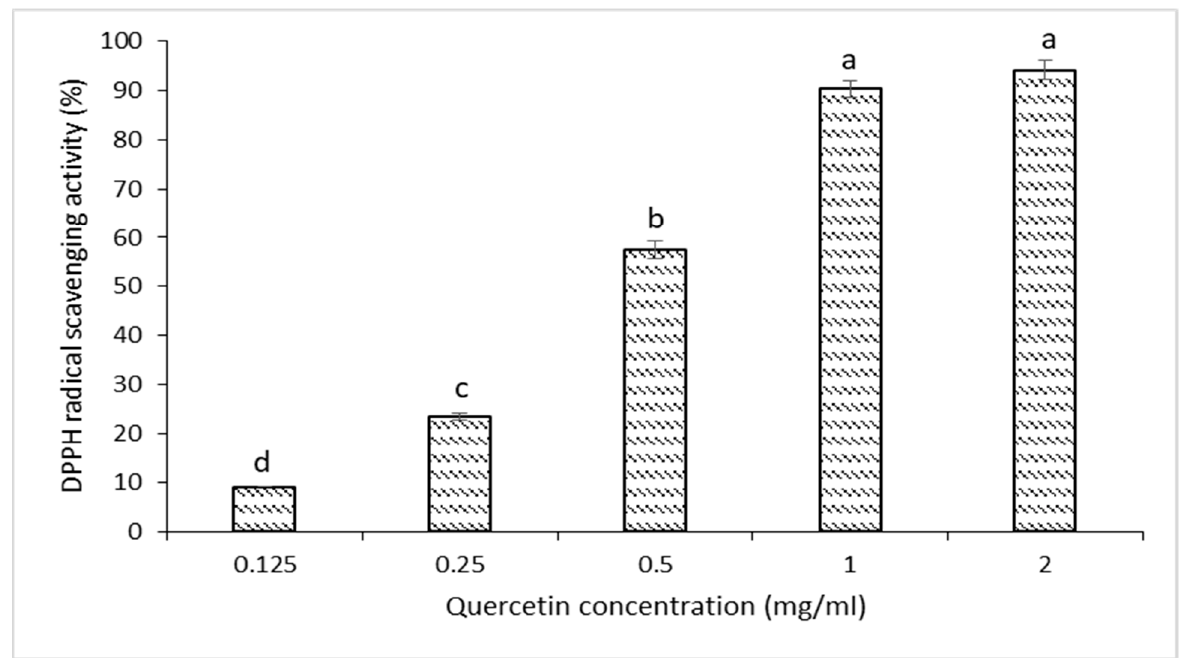
Figure 1. DPPH radical scavenging activity (%) of quercetin. Data are given as means values ± SD. Different letters on the top of data bars indicate significant differences (Tukey’s test, p < 0.05) between mean values.